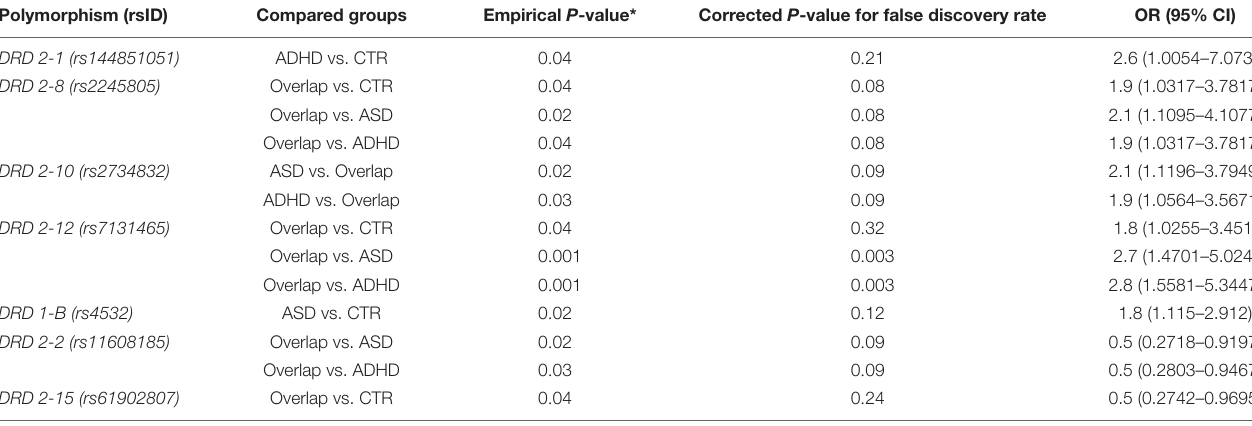
TABLE 6 | The genotype distribution of SNP DRD 2-12 between overlap and the other clinical groups and risk prediction for overlap disorder, under the most significant genetic model of inheritance. # OR db SNP (rsID) Compared groups Most significant Genotype Group1/Group2 Empirical Corrected model (n, %) (95% CI) P -value P -value DRD 2-12 Overlap vs. Controls Dominant C*/C* + A/C* (rs7131465) A/A Overlap vs. ASD Dominant Overlap vs. ADHD Dominant C*/C* + A/C* 0.017 A/A 4 (13)/35 (47) OR, odds ratio; SNP, single nucleotide polymorphism; CI, confidence interval. *Minor allele. Dominant model: homozygous minor allele plus heterozygous vs. homozygous major allele. # OR value associated with the minor allele genotype. Significant SNPs after multiple testing correction